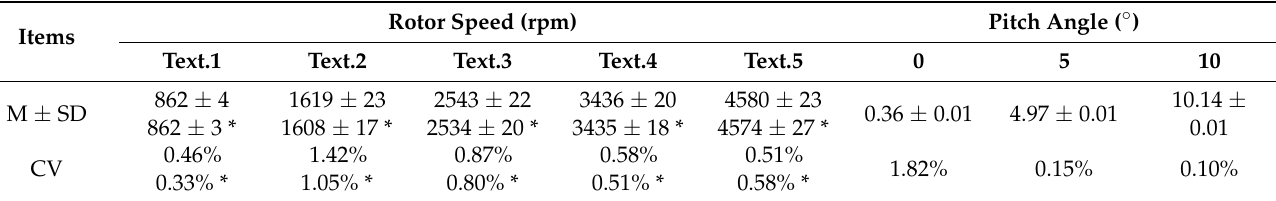
Table 5. The results of the data collection stability